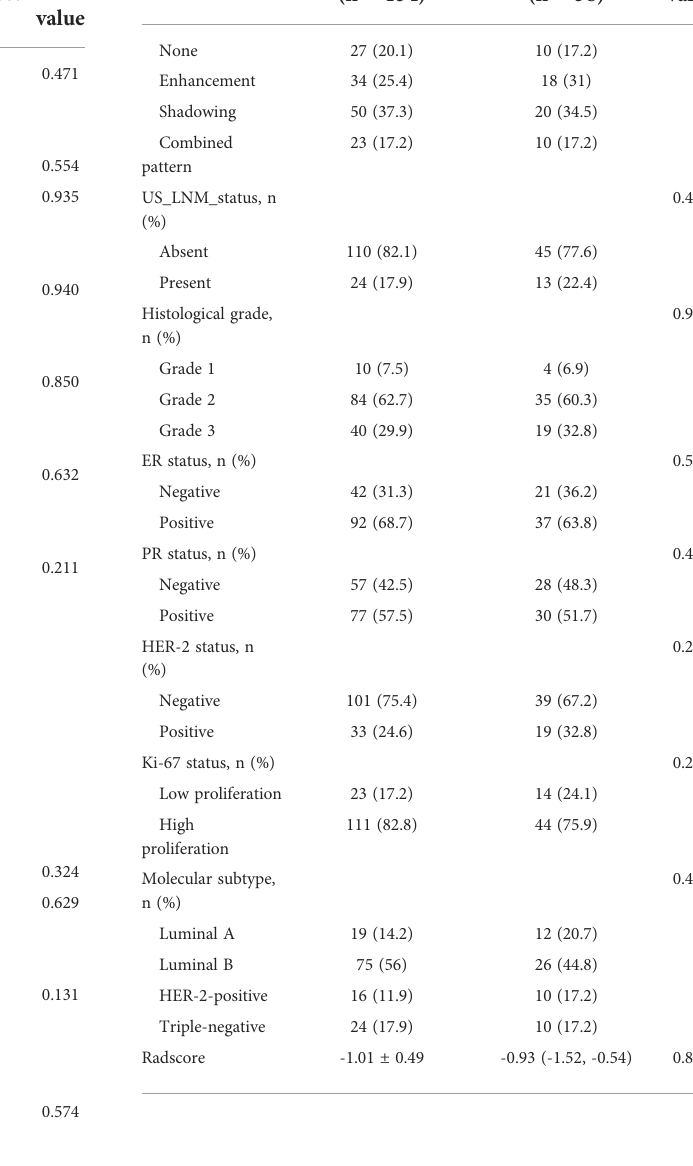
different radiomics models. Hosmer-Lemeshow test was used to evaluate the goodness-of- fi t of the radiomics nomogram. The calibration curve was applied to evaluate the consistency between actual probability and the predicted probability. Decision curve analysis (DCA) was developed to ascertain the clinical utility of different models. A 2-sided P value < 0.05 was considered a statistically signi fi cant difference. All packages of R4.1.3 that were listed in Table 2.